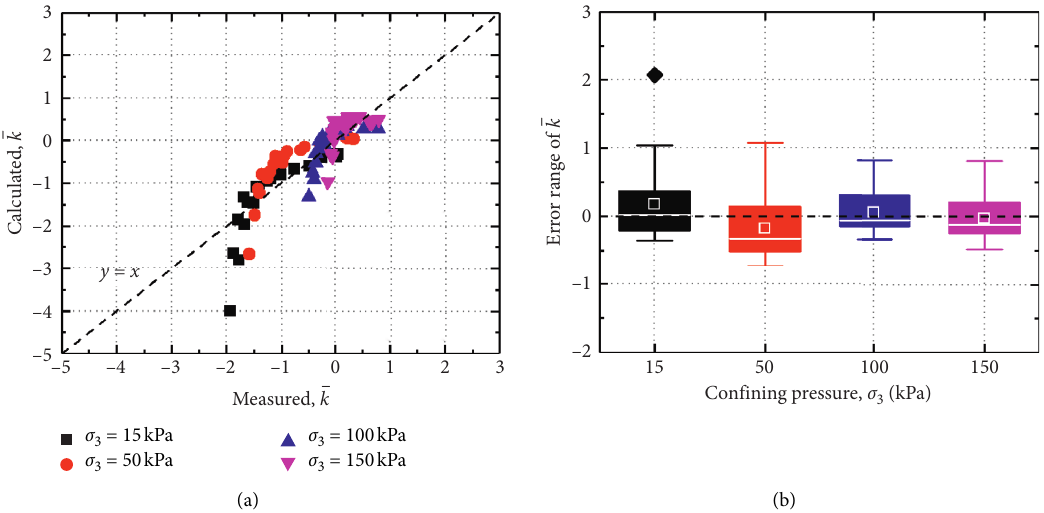
Figure 12: Fitting results. (a) Comparison of calculated and measured results. (b) Box diagram for fitting error.